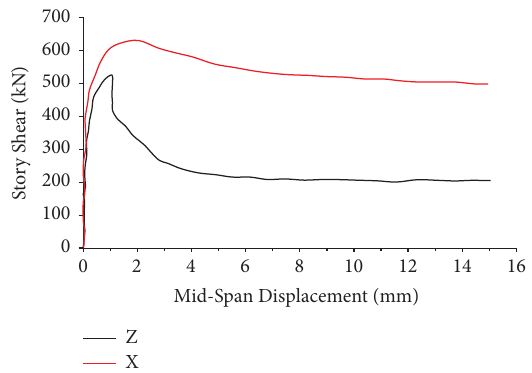
Figure 14: Floor shear chart against displacement at the middle of diaphragm’